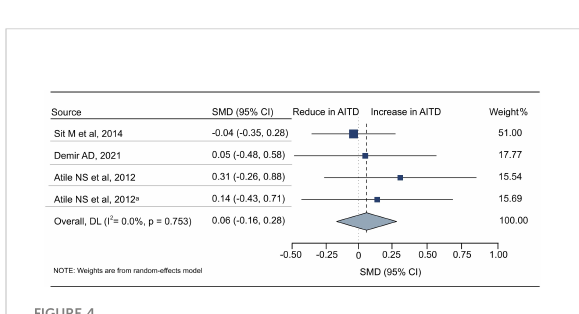
FIGURE 4 Standardized Mean Difference in PDW between the AITD Group and the Control Group. AITD, autoimmune thyroid disease; PDW, platelet distribution width; SMD, standardized mean difference; 95%CI, 95% con fi dence interval. a: the second available data from the same